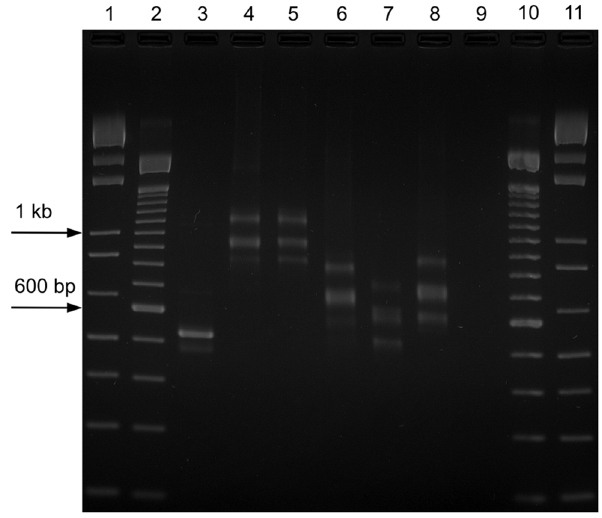
Figure 3. PCR products of the bovine m , d , c 1 to 3, e , and a isotypes. The amplicons of the heavy chain variable domain of each bovine isotype were resolved by 2.5% agarose gel electrophoresis and revealed three distinct products. Lanes 1 and 11:1kb ladder, lanes 2 and 10:100 bp ladder. Lane 1: product of the GAPDH positive control; Lanes 4 and 5: in the products of m and d , a faint lower band was noticed also with differences in size of 100 bp. The middle and upper bands showed strong amplification. Lanes 6 to 8: the dominant product of isotypes c 1 to 3, e , and a was observed in the middle with a size difference of about 100 bp compared to both the upper and the lower band. Lane 9 is the no template negative control of the PCR.